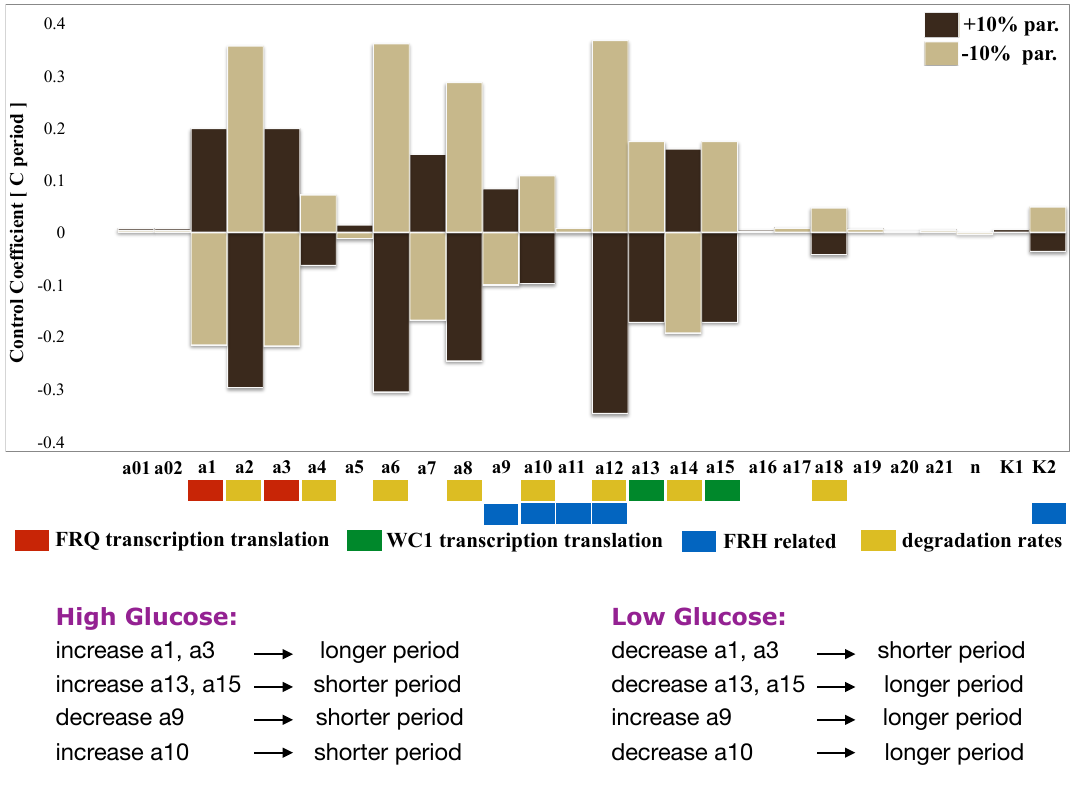
Figure 6. Sensitivity analysis: All parameters were changed by ± 10 percent, and the resulting periods were calculated. Positive and negative period control coefficients indicate period lengthening and shortening,